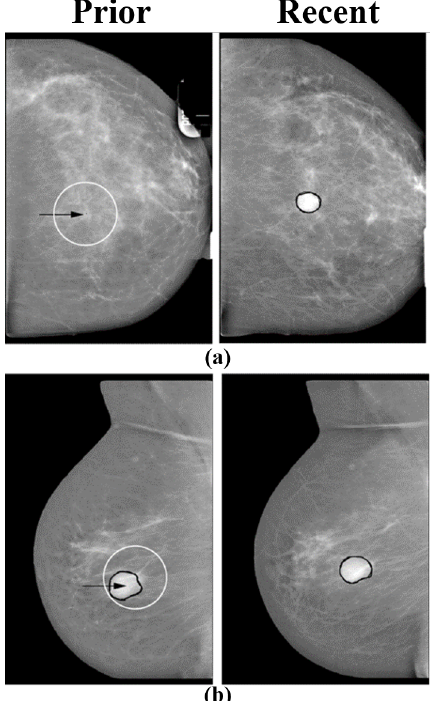
Figure 5. Pairs of temporally sequential mammograms. Right and left images correspond to current and prior views respectively. In each prior view, the arrow indicates the location selected by the regional registration program. ( a ) A case of a malignant mass that was not visible in the prior view. The registration program selected the most probable location in the prior view. ( b ) A case of a benign mass that was similar in the prior and current views. The registration program selected a region in the prior view that was similar to the current region (reprint with permission from